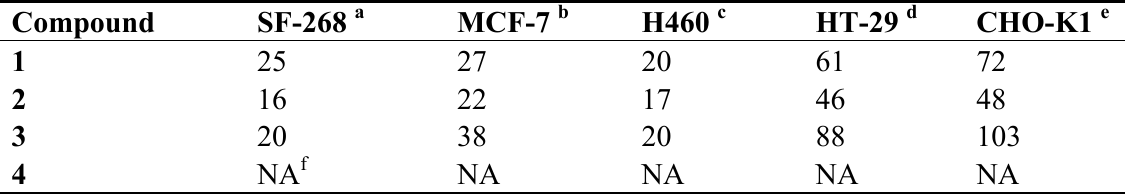
Table 2. Cytotoxicity data [GI (µM)] for compounds 1 – 4 against the human tumour cell 50 lines SF-268, MCF-7, H460, HT-29, the normal human cell line WI38, and the mammalian cell line